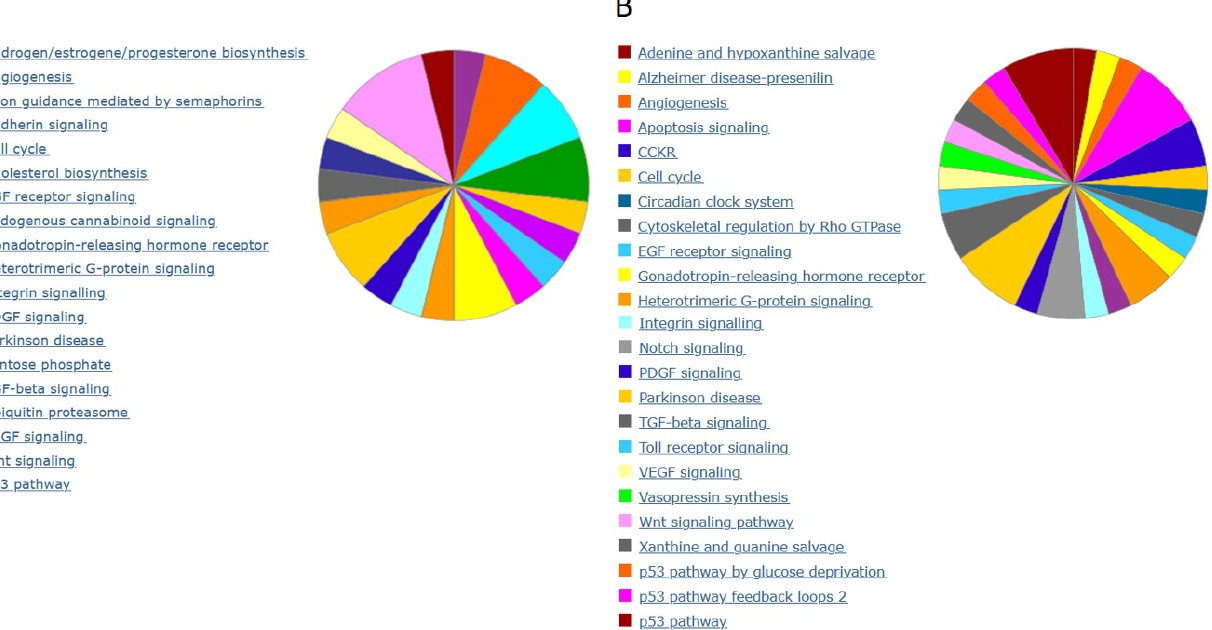
Figure 6. Panther analyses [38,43] of all depicted hypomethylated CpG probes in PCa samples vs. BPH ( A ) and vs . PCa adjacent healthy tissue ( B ) of Figure 4 reveal the involvement of the indicated pathways.